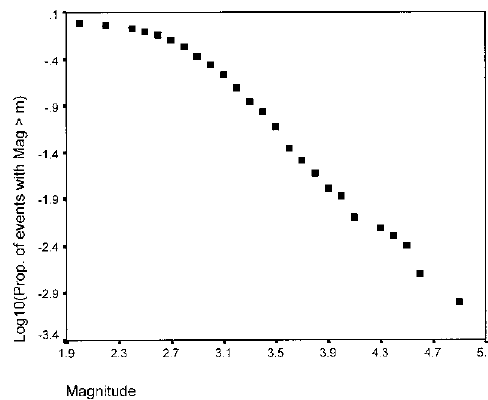
Fig. 14. Cumulative distribution of